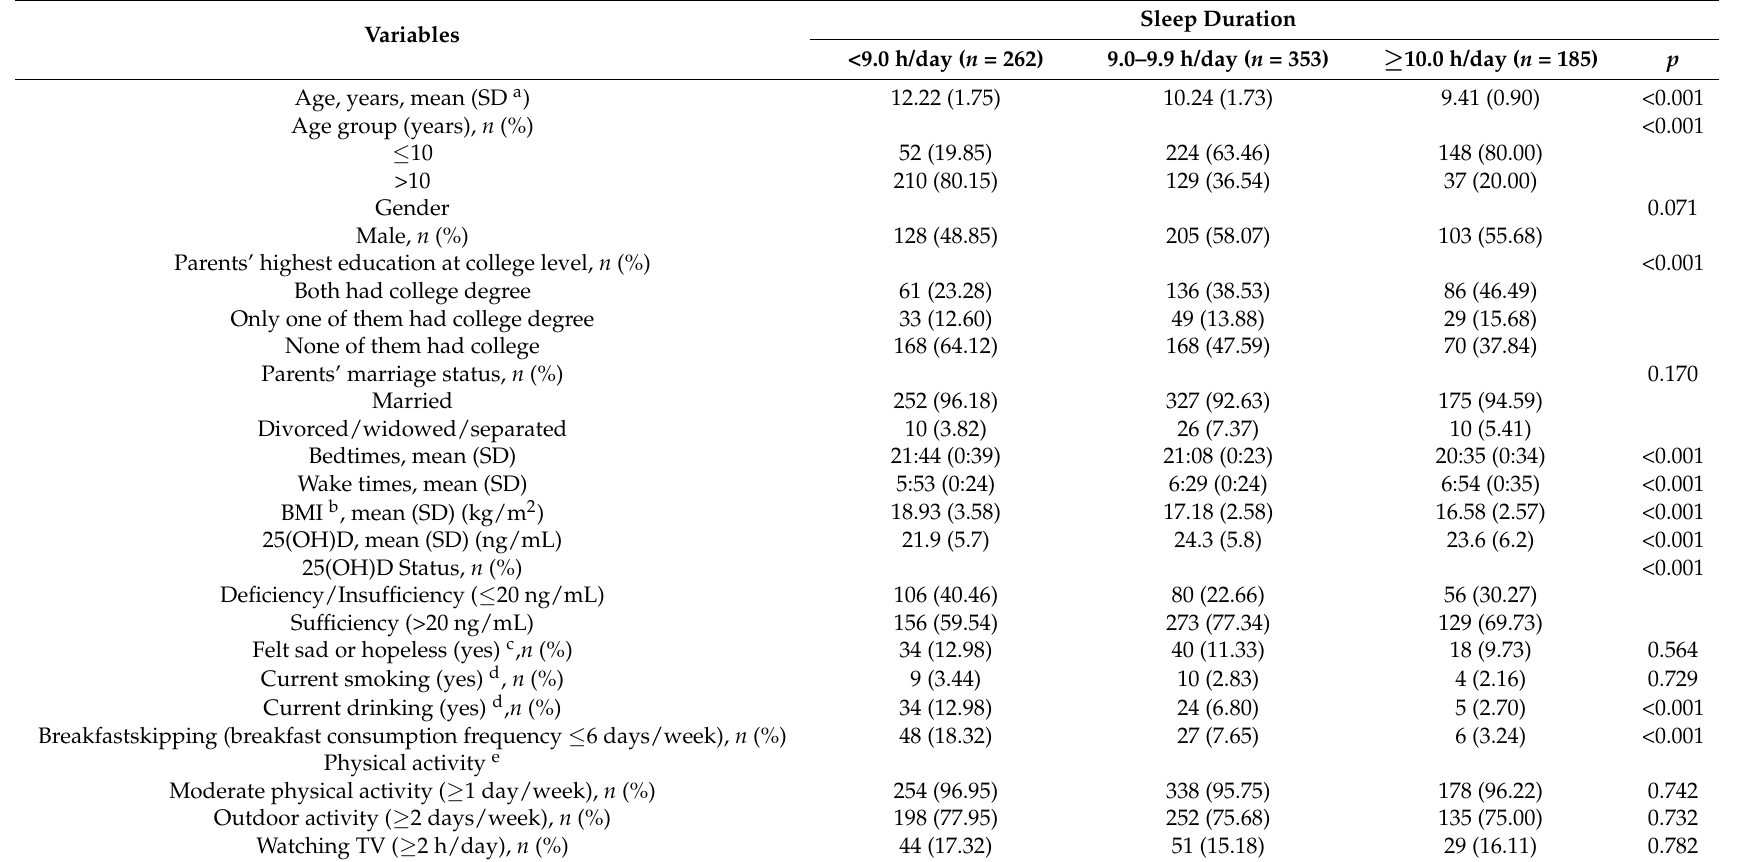
Table 2. Characteristics of the study subjects by sleep duration ( n =